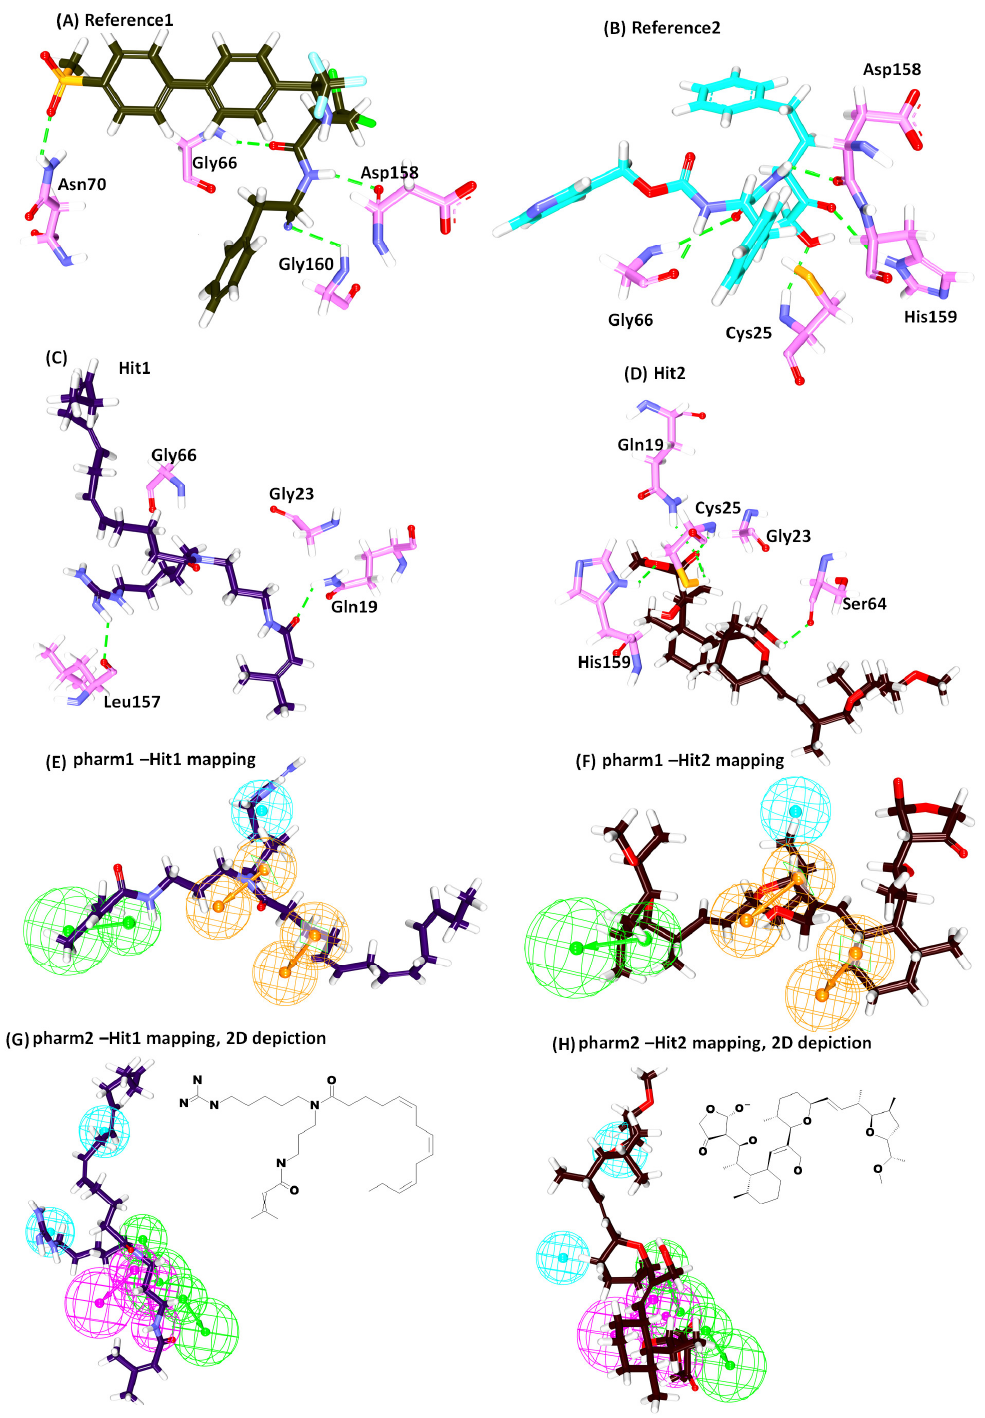
Figure 7. Interactions and the binding pattern of the reference and the Hits. Green dashed lines represent the hydrogen bond interaction ( A ) Hydrogen bond interactions between the protein-reference1. ( B ) Hydrogen bond interactions between the protein-reference2. ( C ) Intermolecular hydrogen bond interactions between the protein-Hit1. ( D ) Intermolecular hydrogen bond interactions between the protein-Hit2. ( E ) Hit1-pharm 1 mapping. ( F ) Hit2-pharm 1 mapping. ( G ) Hit1-pharm 2 mapping and 2D representation of Hit1. ( H ) Hit2-pharm 2 mapping and 2D representation of Hit2.